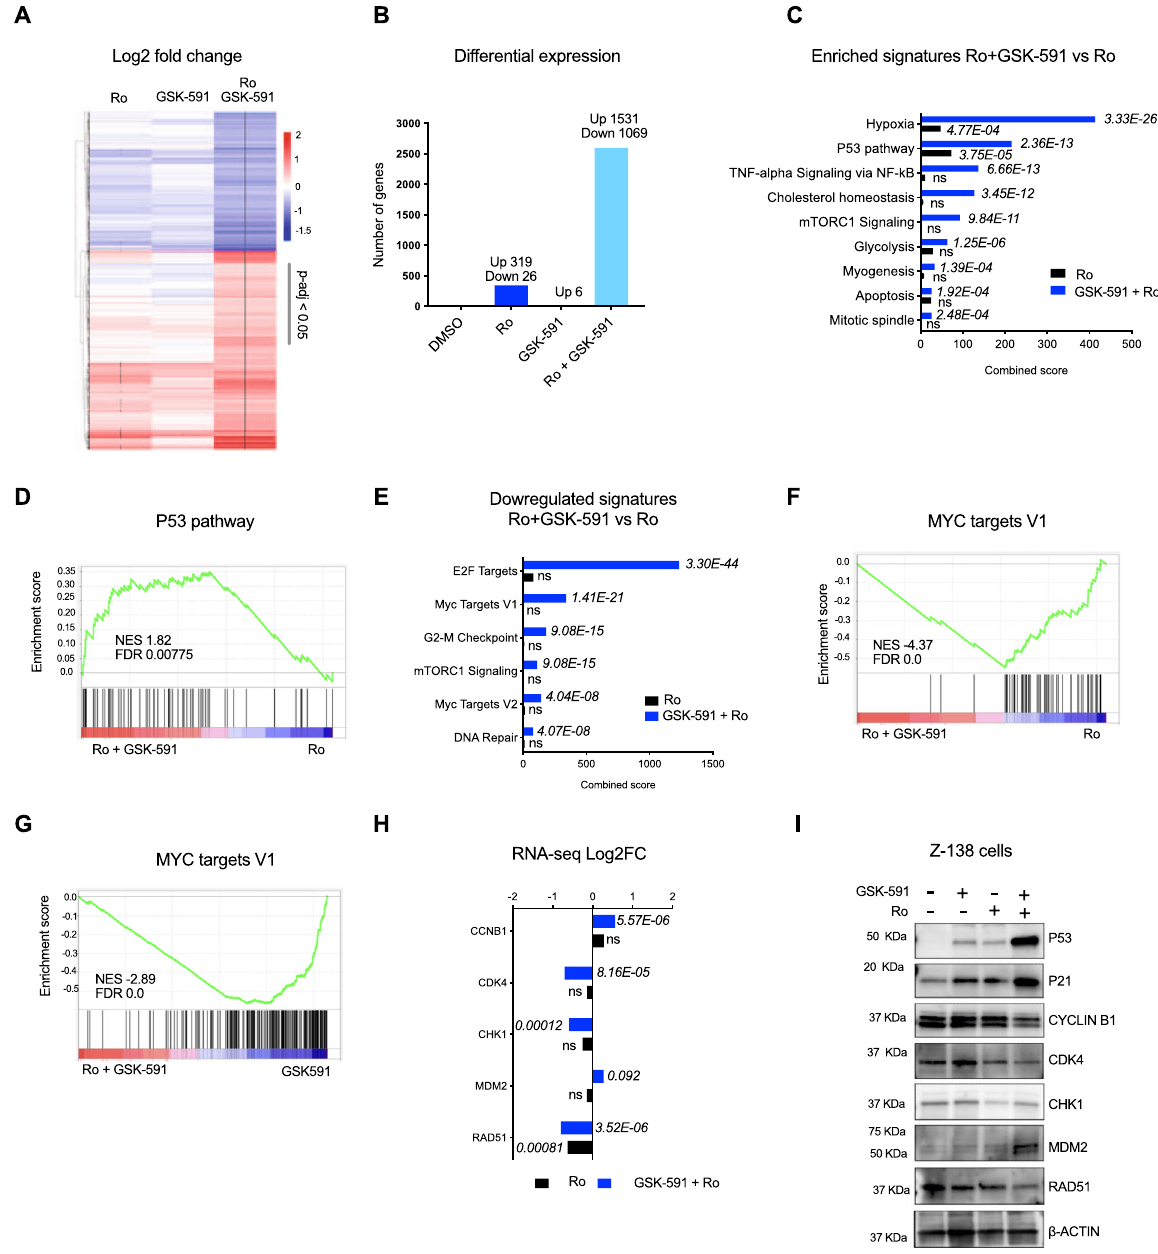
Fig. 4 | Combination of Ro and GSK-591 induces synergistic transcriptome changes. A Heatmap showing differential expression of the top 2600 signi fi cantly enriched (in red) and depleted (blue) transcripts in cells treated with 5uM of Ro, GSK-591 alone or in combination for 24h. Values represent Log2FC, * indicate signi fi cant(adjust p -value<0.05)DESeqgenes,determinedbyone-sidedWilcoxon test. B Bargraphsummarizingthenumberofsigni fi cantDESeqgenesfromAinthe indicatedconditions. C Top signi fi cant enrichedMolecularSignatures (MSigDB) in the upregulated transcripts (1531) upon drug combination vs. Ro alone using ENRICHR analysis. p -values were calculated by Fisher ’ s exact test. D GSEA analysis of differentially expressed genes upon combination of GSK-591 and Ro. P53 signature was positively enriched in the combination vs Ro alone. E Top